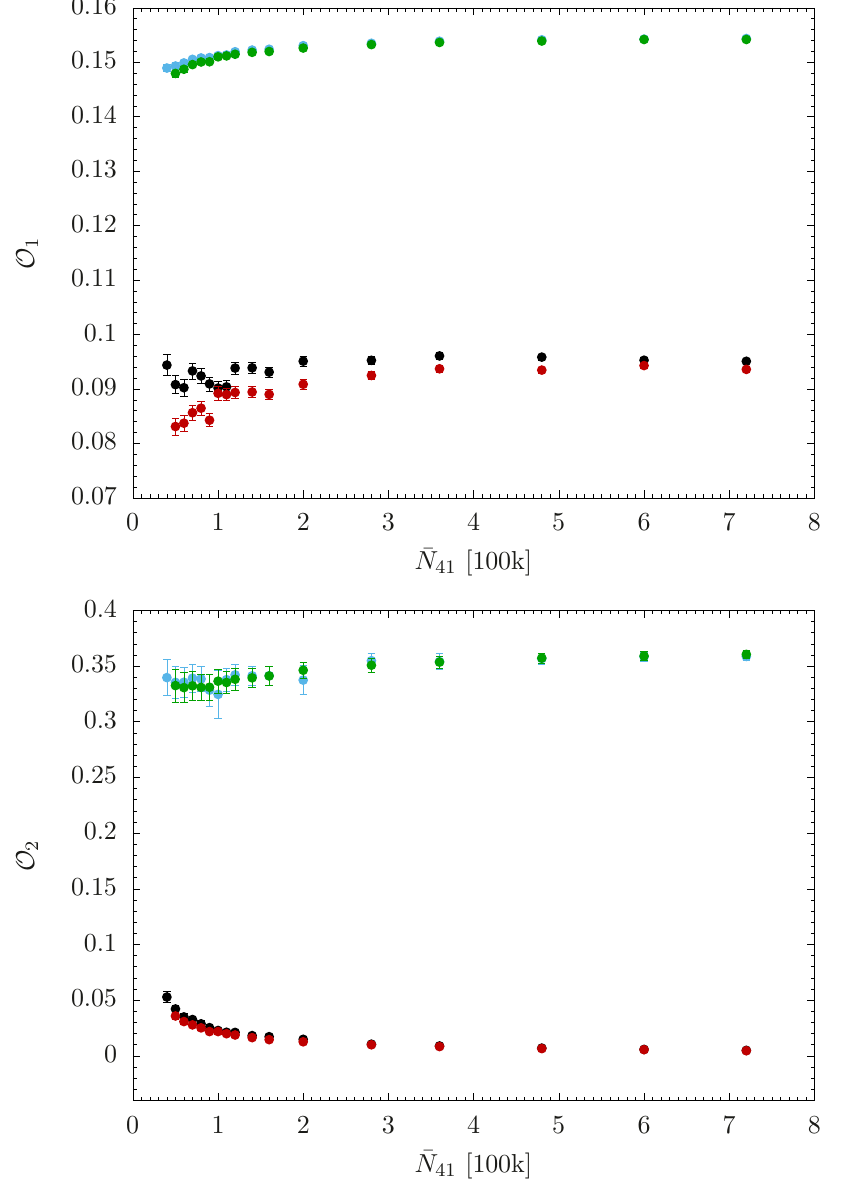
and as a function of (cid:22) N 41 at the endpoints of the hysteresis. O 1 O 2